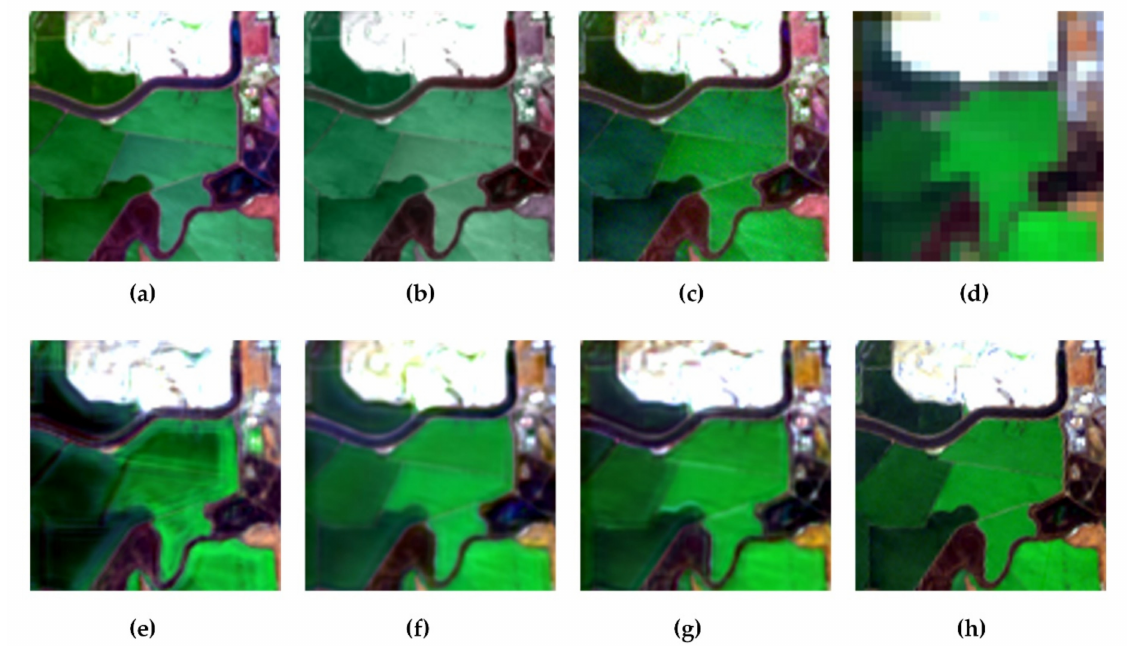
Figure 7. Local enlargements of fusion result of San Francisco. ( a ) CNMF; ( b ) JNMF; ( c ) DPLM; ( d ) LR HS image; ( e ) TCNNF; ( f ) DiCNN; ( g ) CpCNN; ( h ) Reference HR HS image.